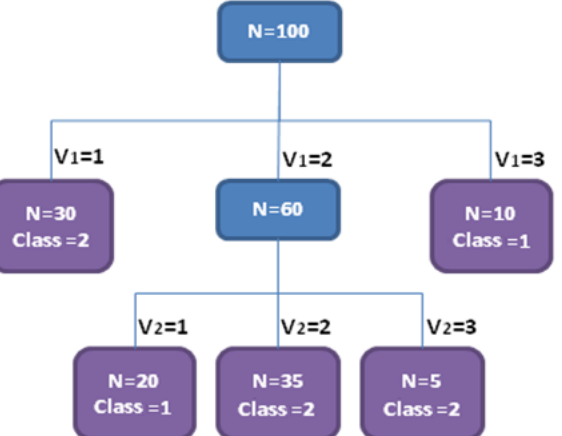
Figure 2. Classification tree, where N is the number of items of the training set in each node, while V 1 and V 2 are respectively the variables chosen for partitioning in levels 1 and